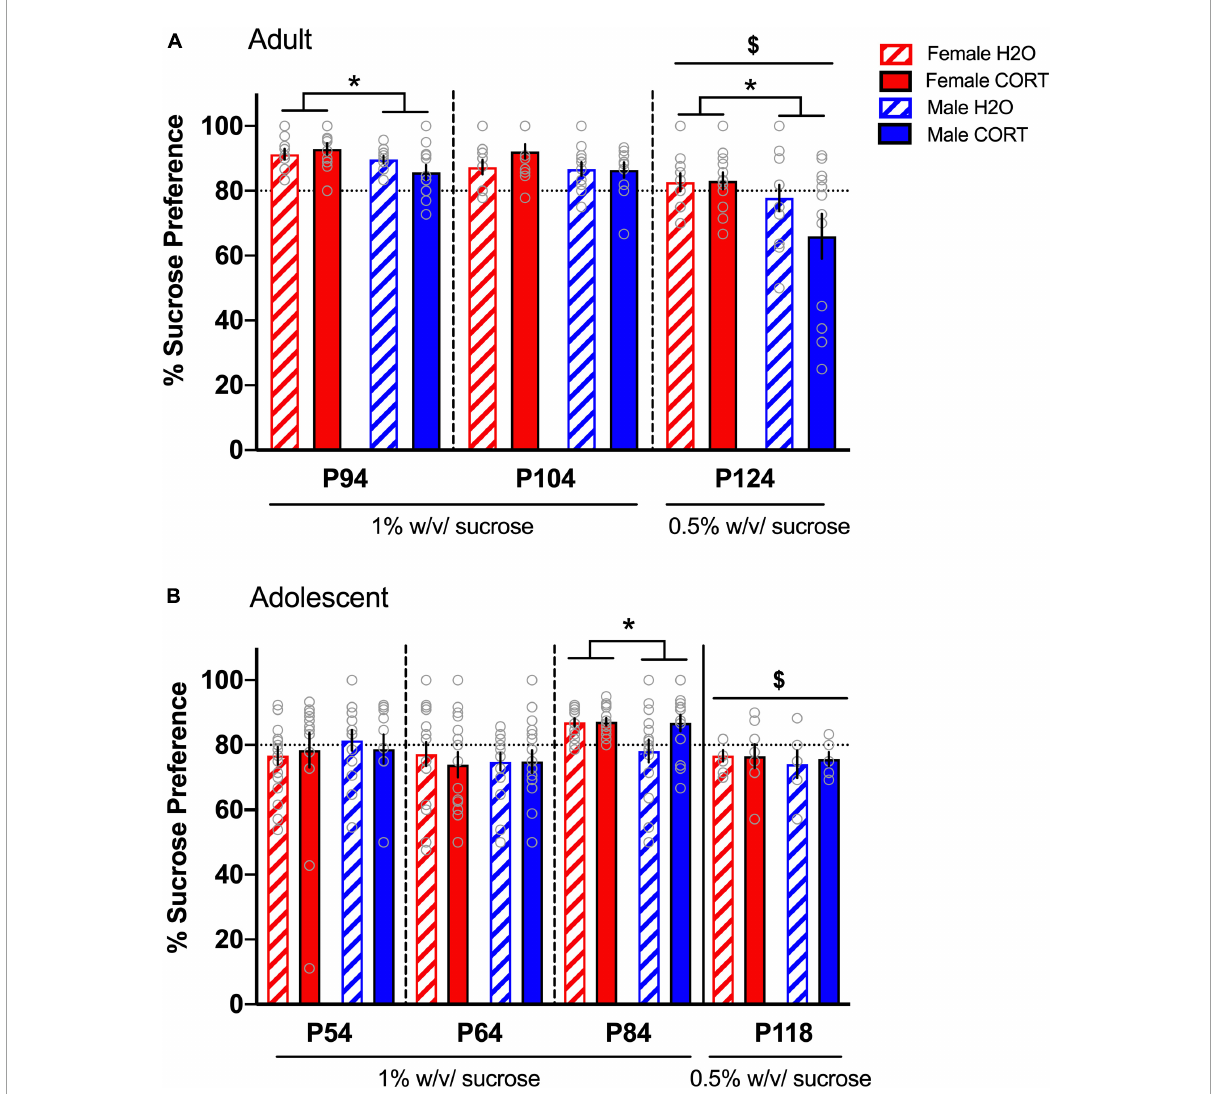
FIGURE3 Increased sucrose preference in females emerges in adulthood, but is not altered by chronic CORT treatment. In adult-treated rats (A) , female rats showed greater preference than male rats during the first SPT. Sucrose preference was significantly reduced during the final SPT when the sucrose concentration was reduced from 1% to 0.5%, and male CORT-treated rats exhibited a trend ( p = 0.15) for a reduction in preference compared to their H 2 O-treated counterparts. In adolescent-treated rats (B) , sucrose preference was highest on the third test when the rats reached adulthood (p84), and lowest when the concentration was reduced to 0.5%. Only during the third SPT was increased preference in adolescent-treated females evident, indicating that sex differences in hedonic responses emerge in adulthood. * p < 0.05 (male vs. female); $ p < 0.001 (SPTs at 0.5% vs. SPTs at